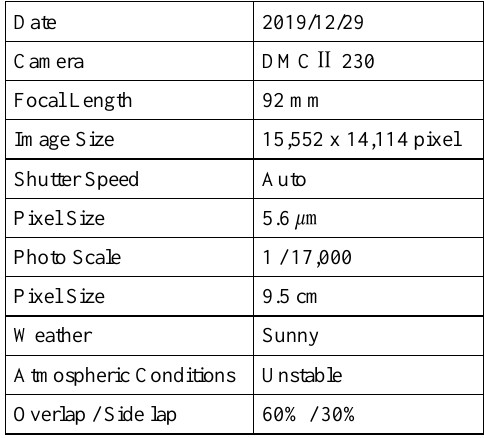
Table 1. Specifications at the time of photography